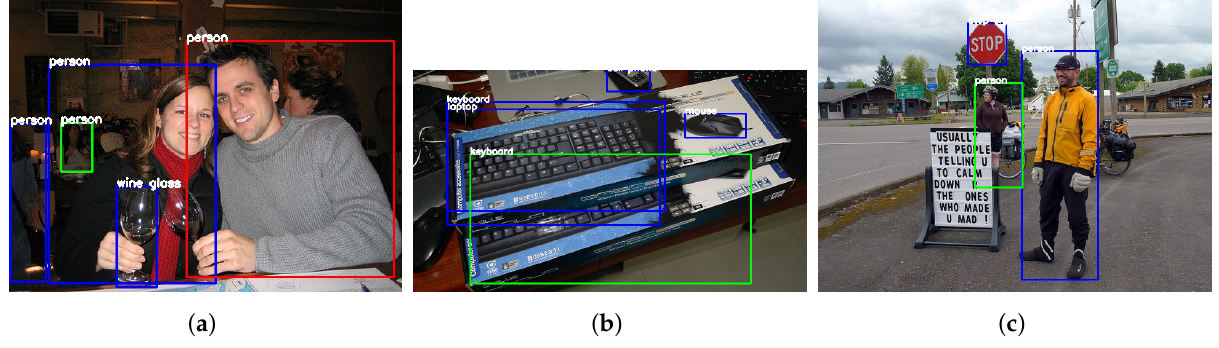
Figure 6. Some failure cases. The results ( a – c ) are all from MS COCO 2015 test